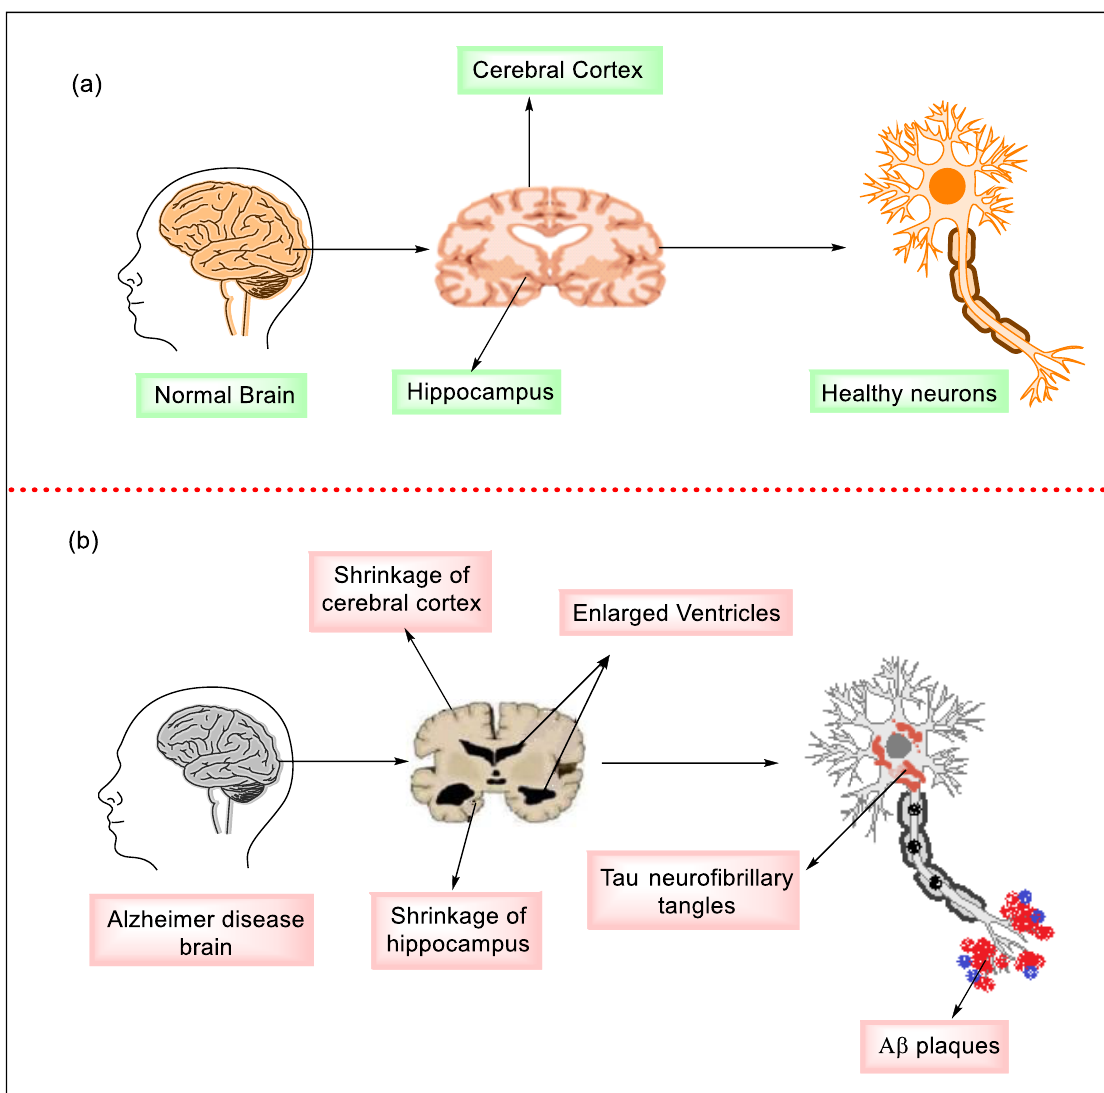
Figure 1. The physiological structure of the brain and neurons in ( a ) healthy brain and ( b ) Alzheimer’s disease (AD) brain.